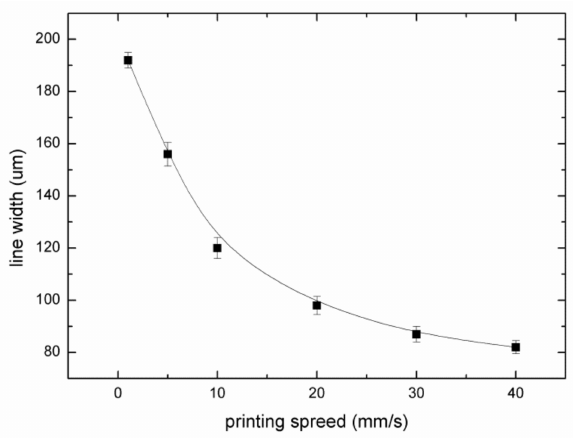
Figure 8. The relationship between the printing speed and the line width.